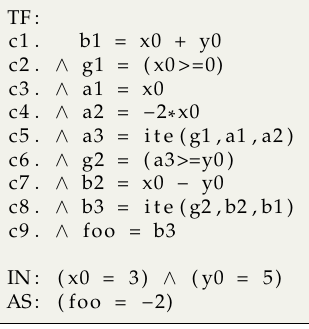
Figure 2. Static single assignment (SSA) representation of method foo.